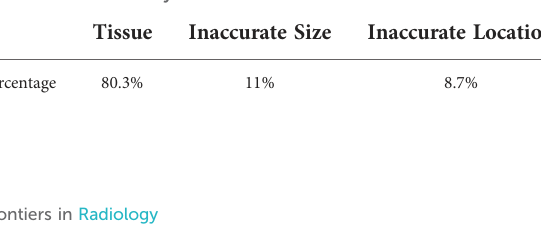
TABLE 2 Statistic Analysis for False Positive Nodule